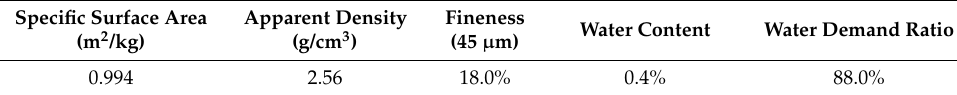
Table 3. Physical properties of fly ash.